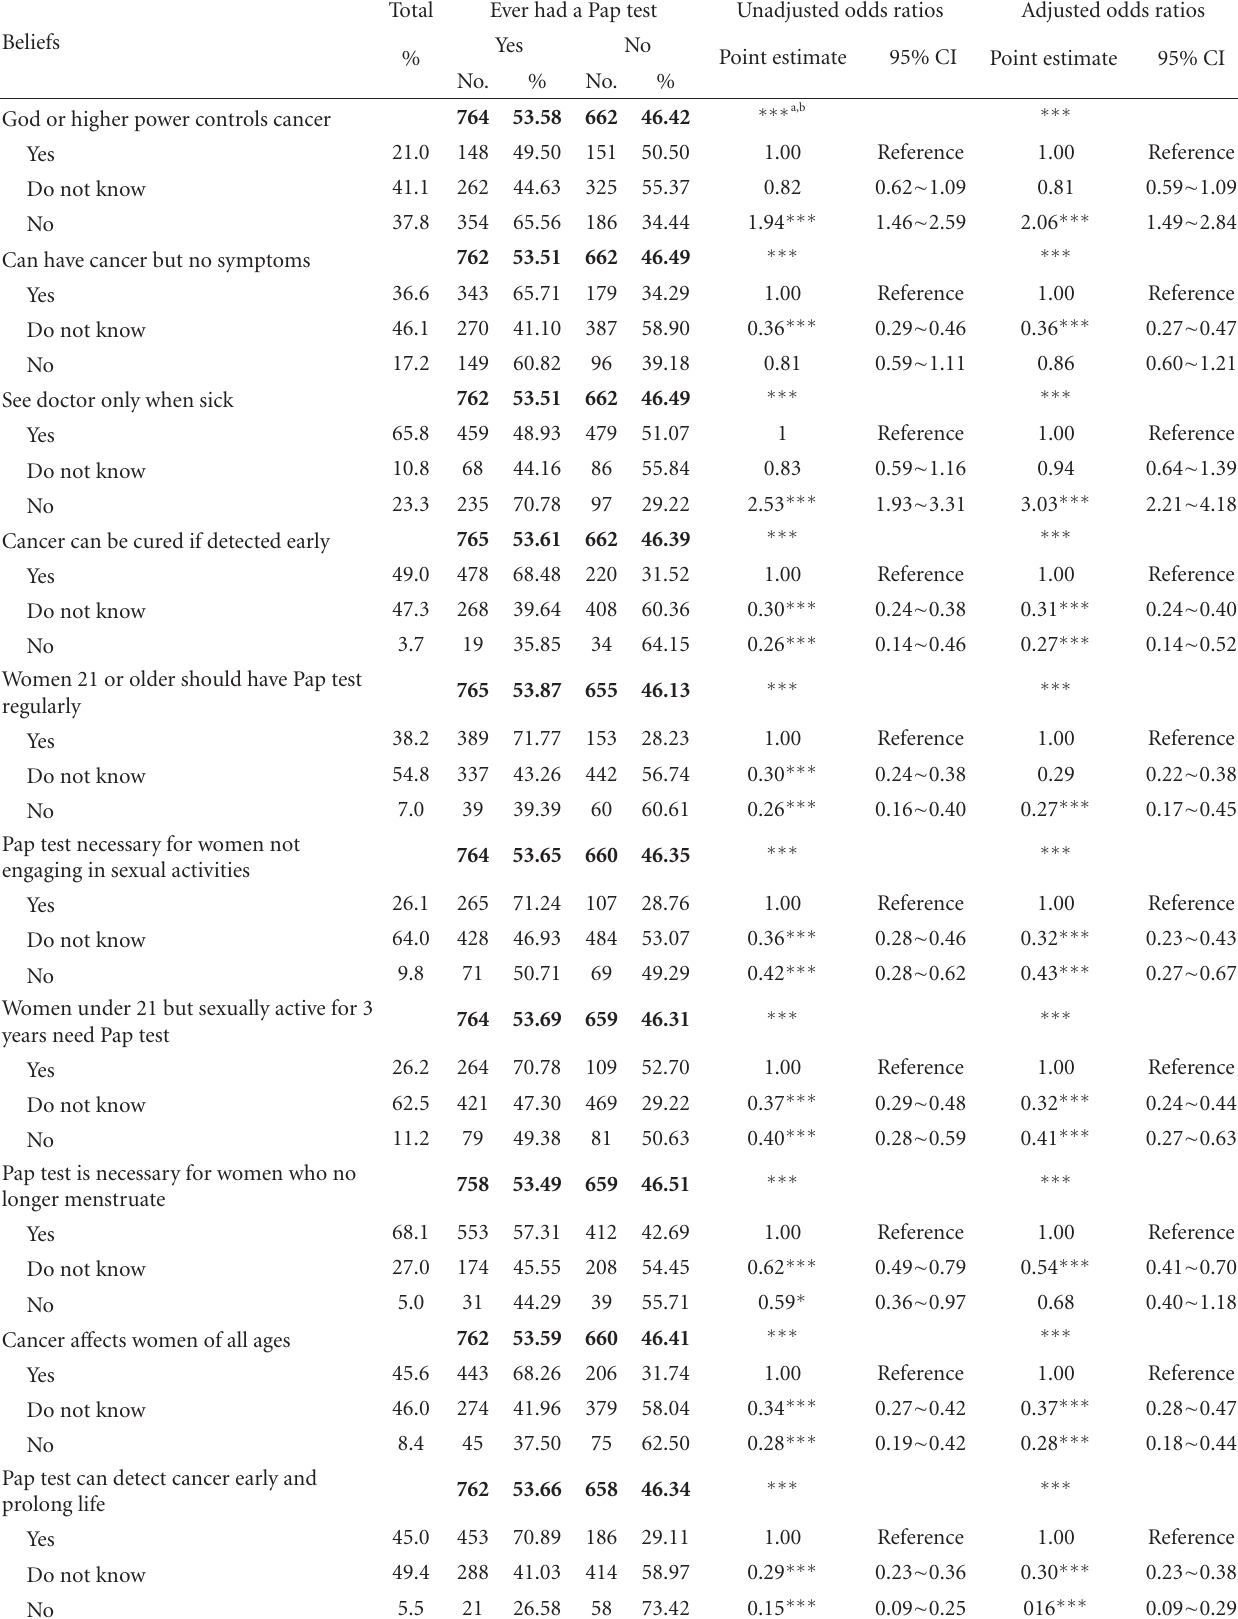
Table 3: Associations between Papanicolaou (PAP) testing and knowledge, attitudes, and